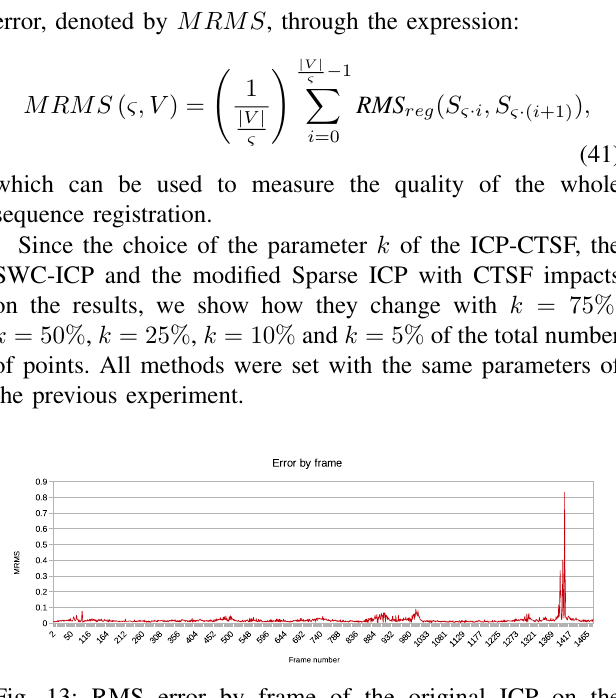
Fig. 13: RMS error by frame of the original ICP on the sequence #03118 .